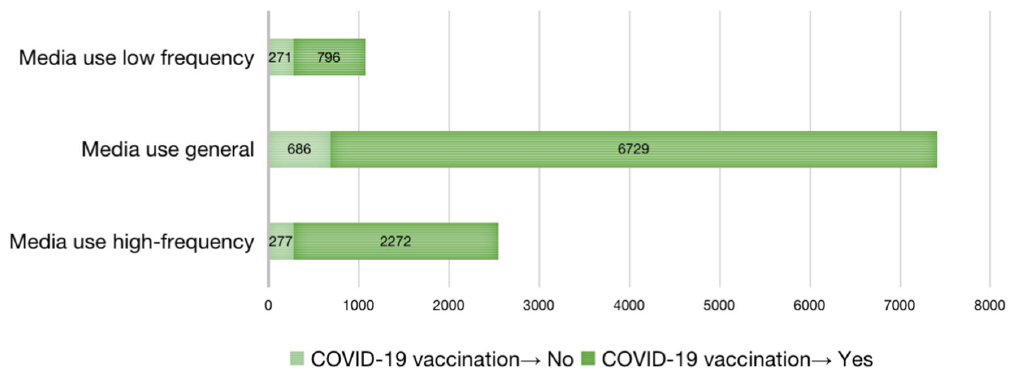
Figure 2. Vaccination statistics for COVID-19 among respondents.